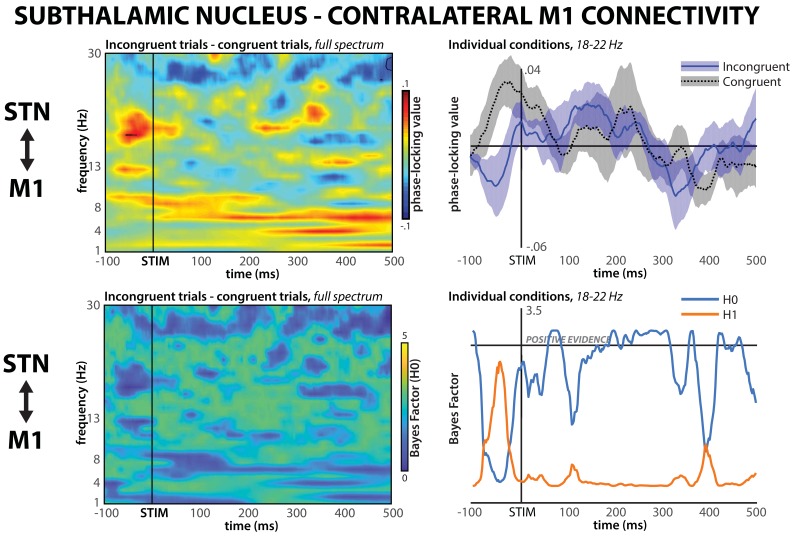
STN – contralateral M1 connectivity during conflict.Top row: PLV analysis for contralateral M1-STN functional connectivity. Details are the same as Figure 5A. Bottom row: Bayes factor analysis used to quantify evidence for the null hypothesis for the data depicted in the top row. Left: full-spectrum Bayes factor quantifying evidence for the null hypothesis (H0); right: evidence for null and alternative hypothesis (H1) for the frequencies that yielded the strongest connectivity in Figure 5.